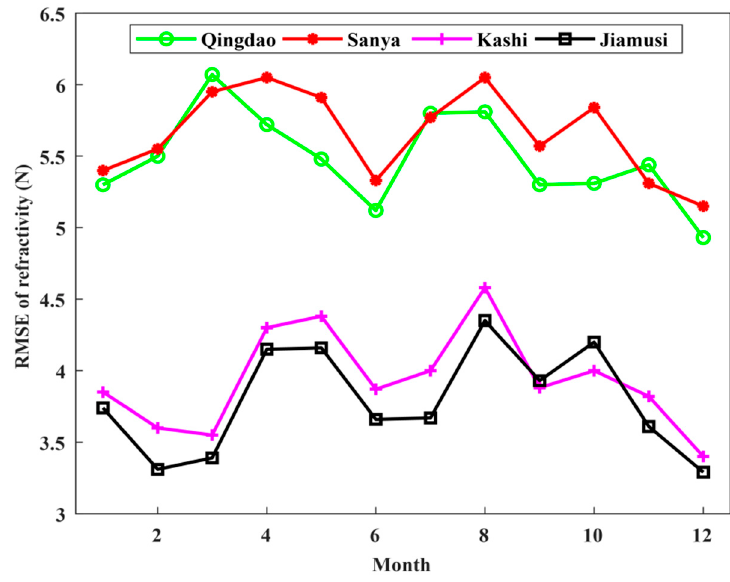
Figure 10. The RMSE of refractivity profile in different month.